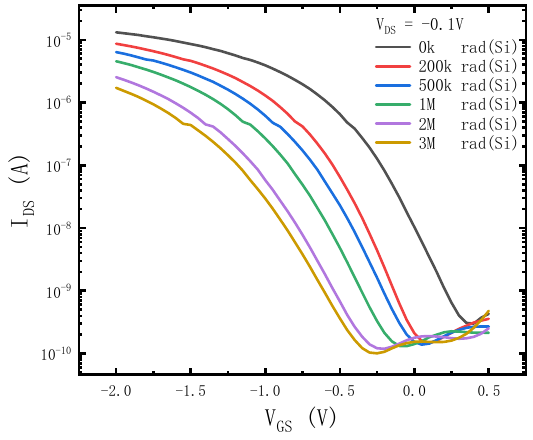
Figure 2. Transfer characteristic curves after irradiation.